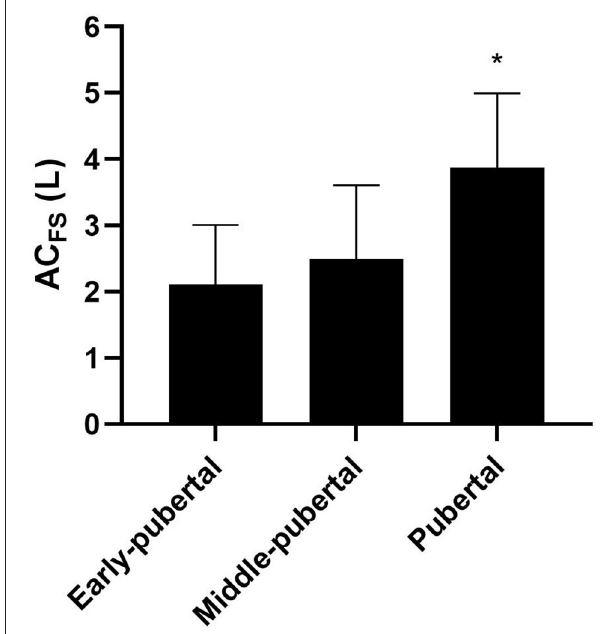
FIGURE 4 | Mean and standard deviation of AC FS (anaerobic contribution) determined in free-swimming in different maturation stages. *Significantly higher than early-pubertal and middle-pubertal.